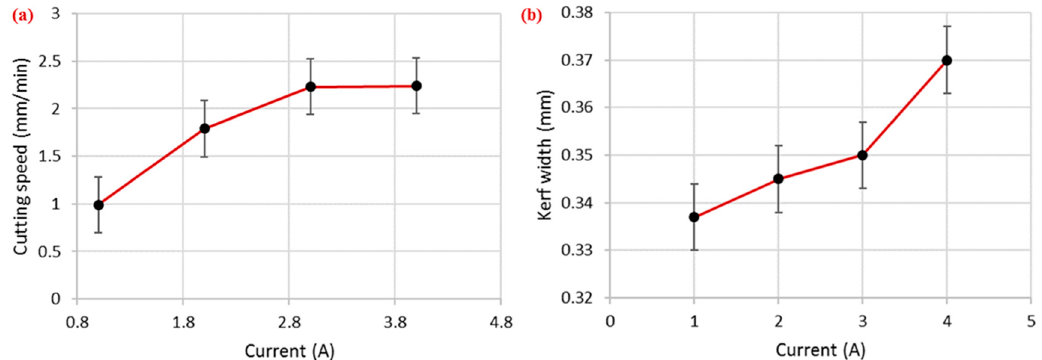
Figure 3. Effect of current on ( a ) cutting speed and ( b ) kerf width. Figure 3. E ff ect of current on ( a ) cutting speed and ( b ) kerf width.